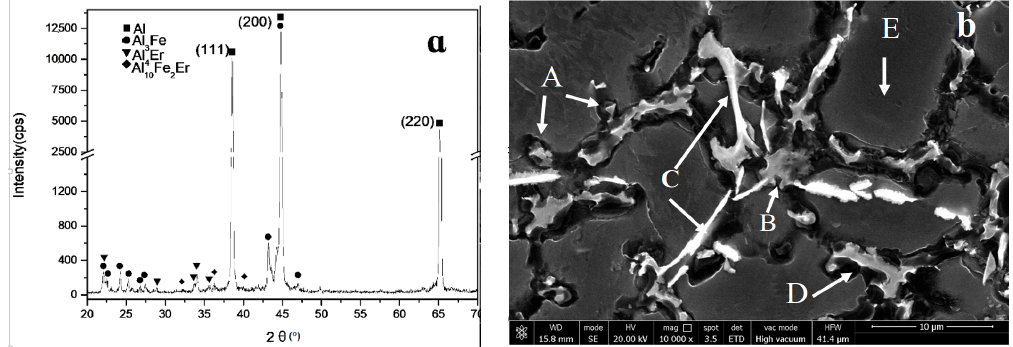
Figure 2. X-ray diffraction (XRD) analysis ( a ) and scanning electron microscopy (SEM) image ( b ) of the as-cast alloy. Table 1. Energy-dispersive X-ray spectroscopy (EDS) analysis of the phases in the tested alloy. Element （ at.% ）